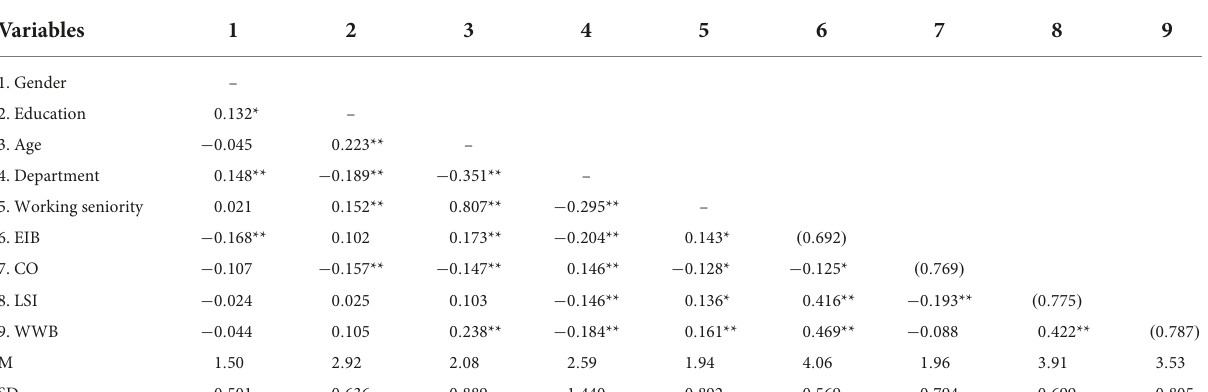
TABLE 4 Means, standard deviations (SDs), and correlations.